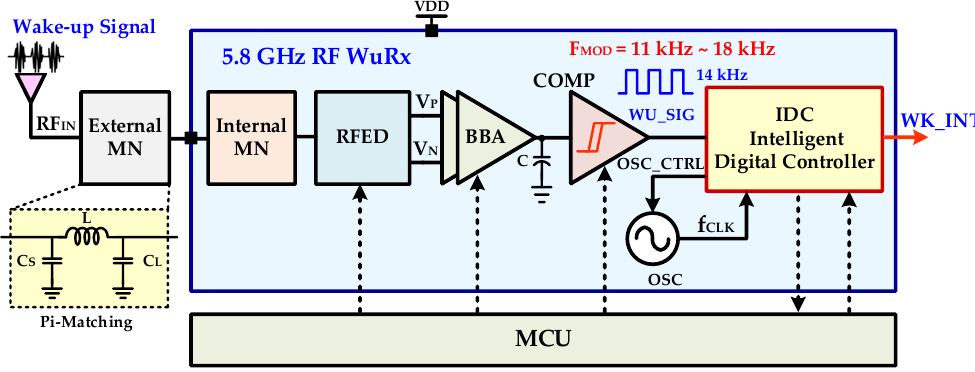
Figure 5. Proposed RF wake-up receiver architecture.